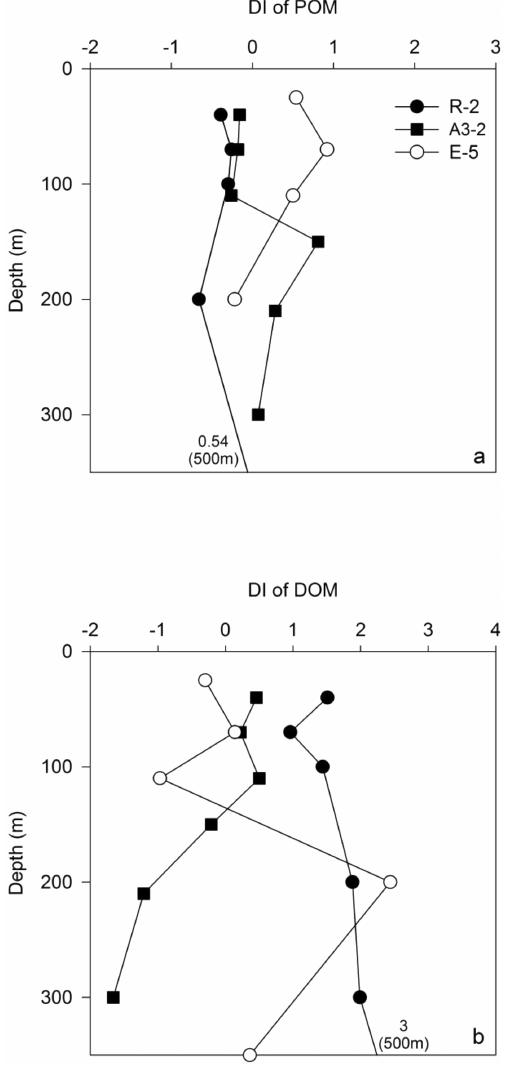
Figure 3. Proportion of D-amino acids (%D-AA) versus total amino acids (AA) in the (a) particulate and (b) dissolved fractions for three representative stations (R-2, A3-2, E-5) at 0–350m depth.